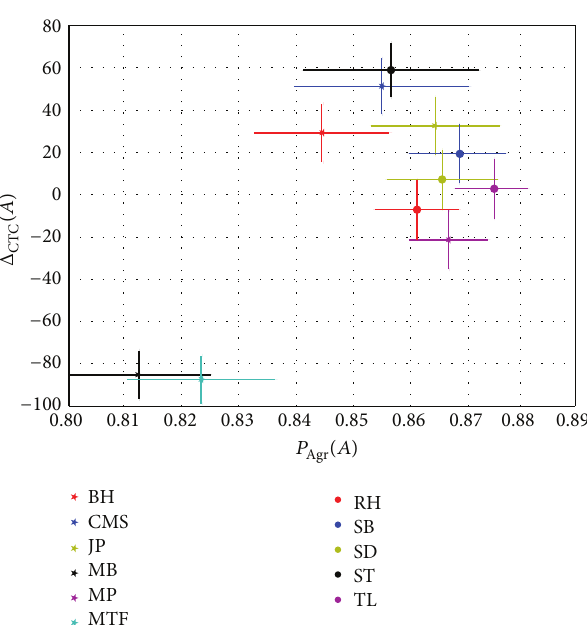
Figure 3: The average agreement for the observers plotted against thedifference in number of foundCTCsbetween theobservers. Bars indicate the standard errors around the